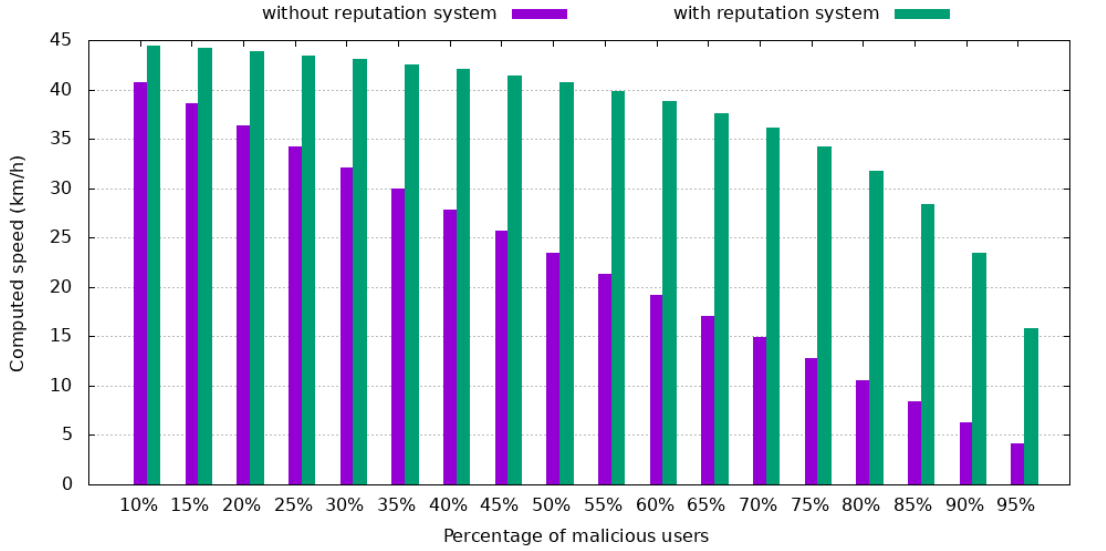
Figure 18. Impact of malicious users reporting lower speeds.